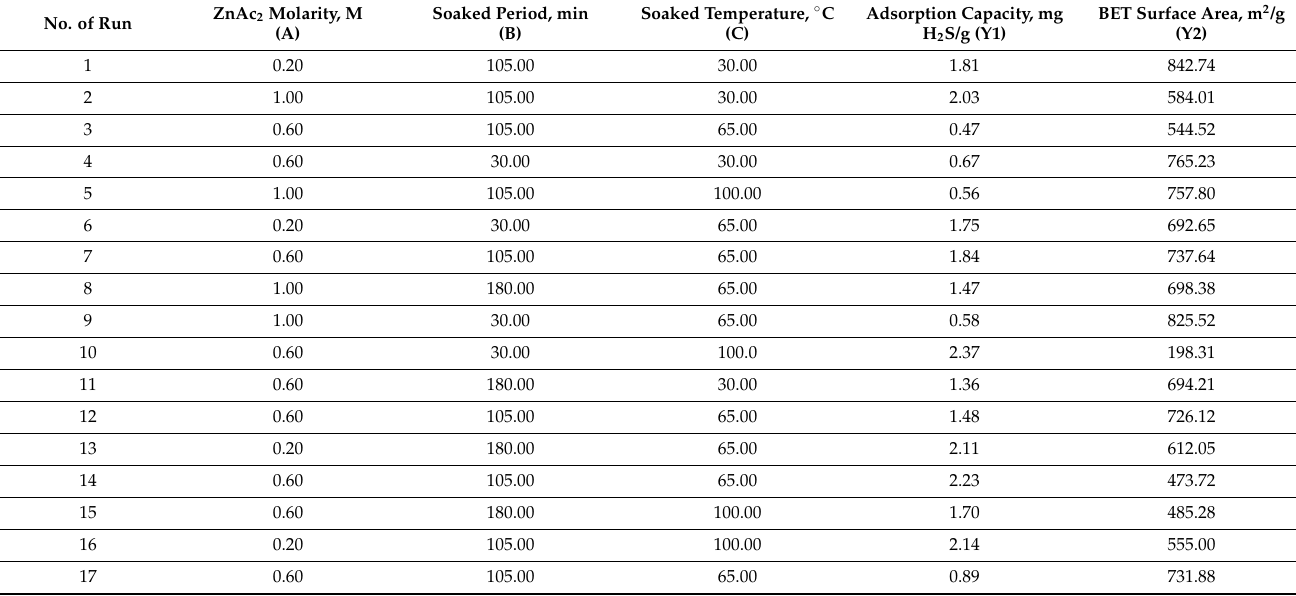
Table 3. Box–Behnken and experimental data of responses’ adsorption capacity and BET surface